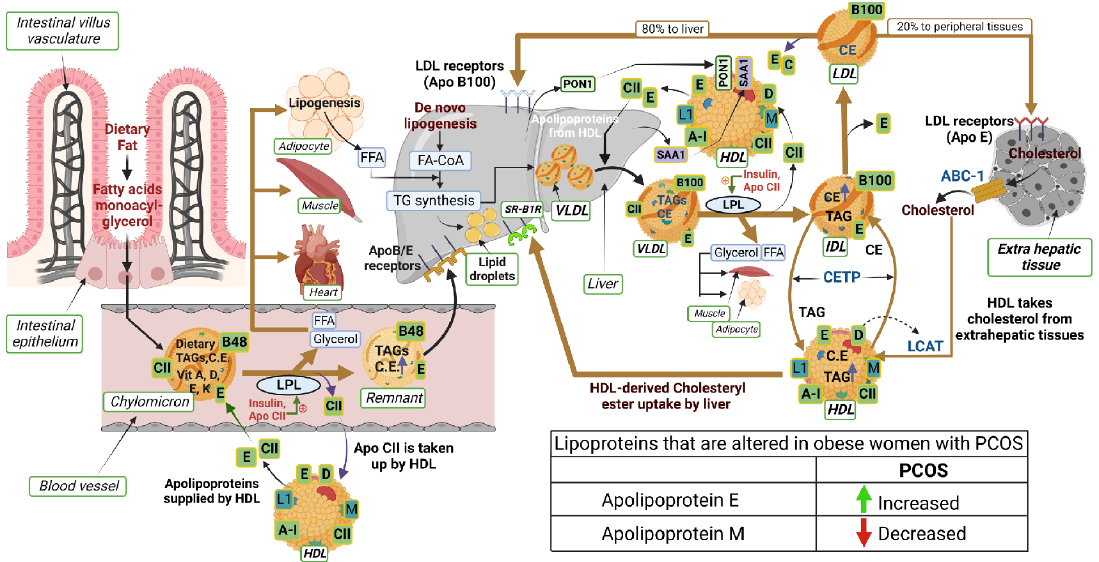
Figure 1. Schematic illustrating the interactions of proteins and lipids in the pathways of lipoprotein metabolism. The lipoproteins that are changed in obese subjects with PCOS are indicated in the table (bottom right in the illustration). An upward green arrow indicates an increase and a downward red arrow indicates a decrease in lipoproteins in PCOS.